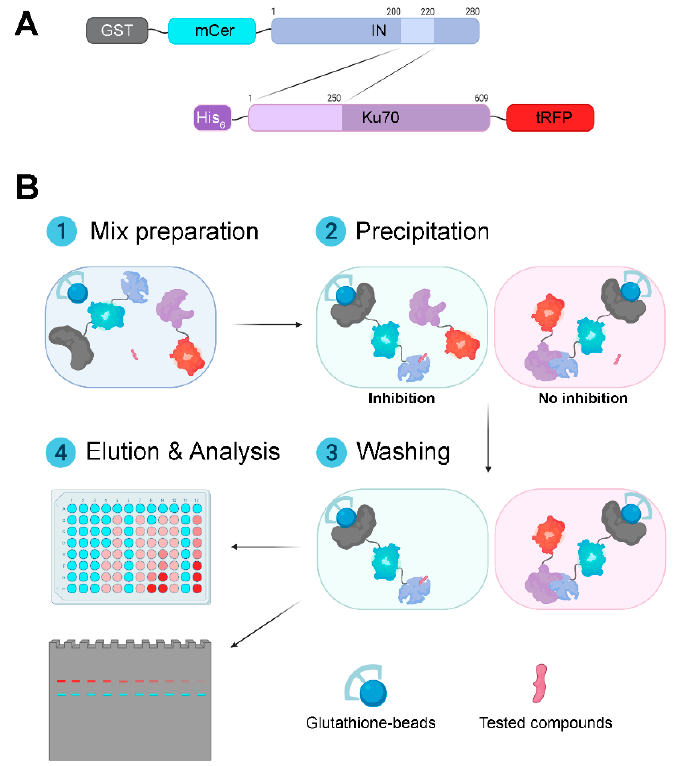
Figure 1. General scheme of the fluorescent assay for the discovery of Ku70-IN inhibitors. ( A ) Schematic illustration of recombinant Ku70 and HIV-1 integrase fused to affinity tags and fluorescent proteins used in the assay. ( B ) The pipeline of the fluorescent assay for the discovery of Ku70-IN inhibitors. On the first step, FP-tagged proteins are mixed with tested compounds in a pull-down buffer. On the second step, glutathione-coated beads are also added to the mix to precipitate GST-mCer-IN and GST-mCer-IN/His6-Ku70-tRFP. After washing of unprecipitated proteins (the third step) GST-mCer-IN and co-precipitated His6-Ku70-tRFP are eluted from beads under the mild denaturing conditions without heating to prevent loss of fluorescence of FP-tags. The level of mCer and tRFP can be assayed in plate-fluorometer or using gel-documentation station after separation of proteins in SDS-PAGE. The tRFP signal normalized to the mCer signal is used as a measure for inhibitors’ effectiveness. The additional points should be analyzed in the same experiment. One of them is a mix of all components except the tested compound. Another one is a mix, in which GST-mCer-IN is replaced by GST-mCer. The level of tRFP signal normalized to the mCer signal, in this case, is taken as the background.